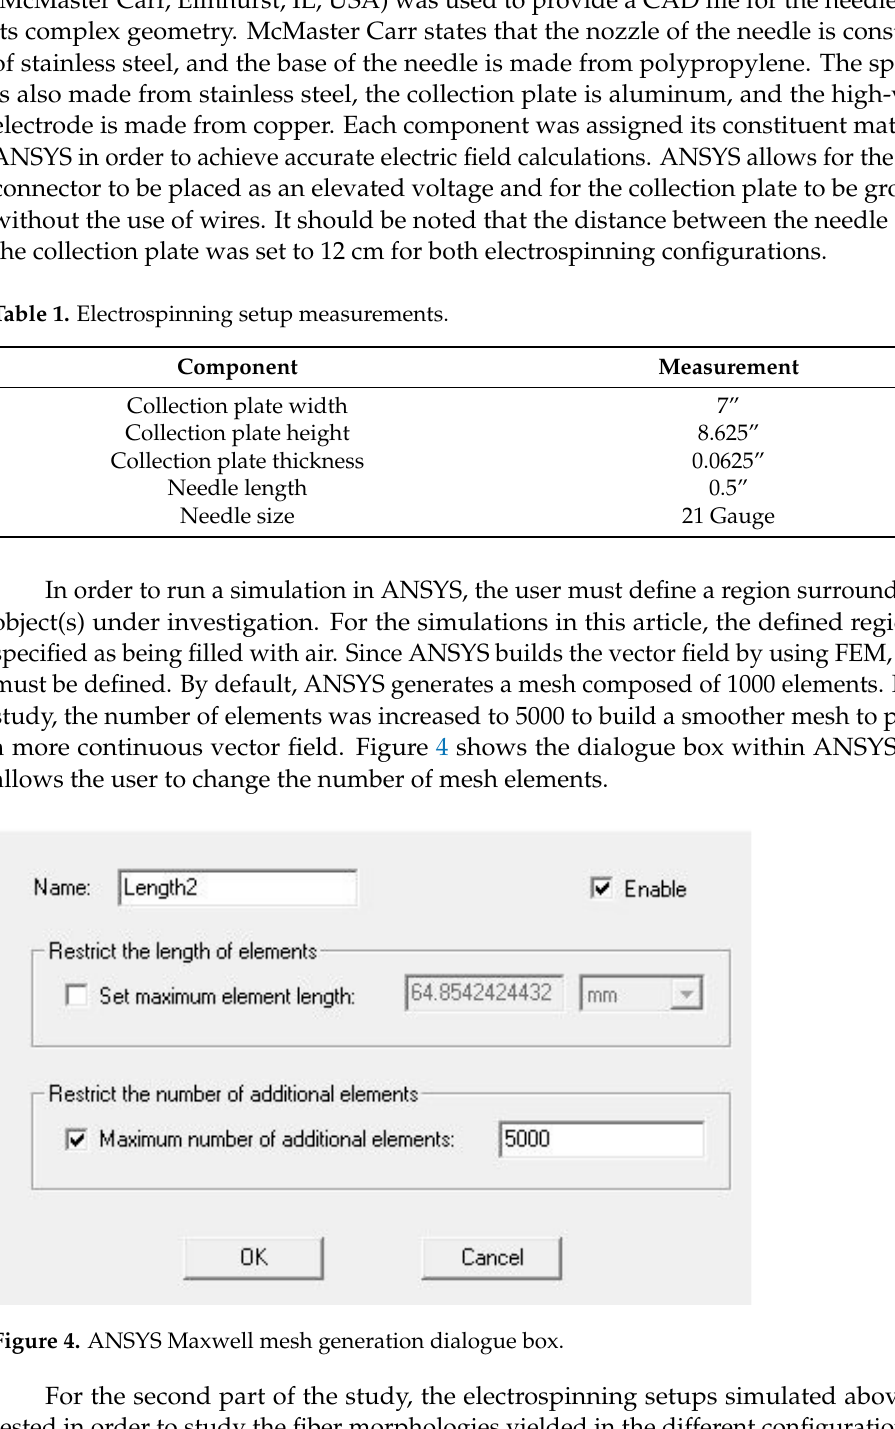
Table 1. Electrospinning setup measurements.